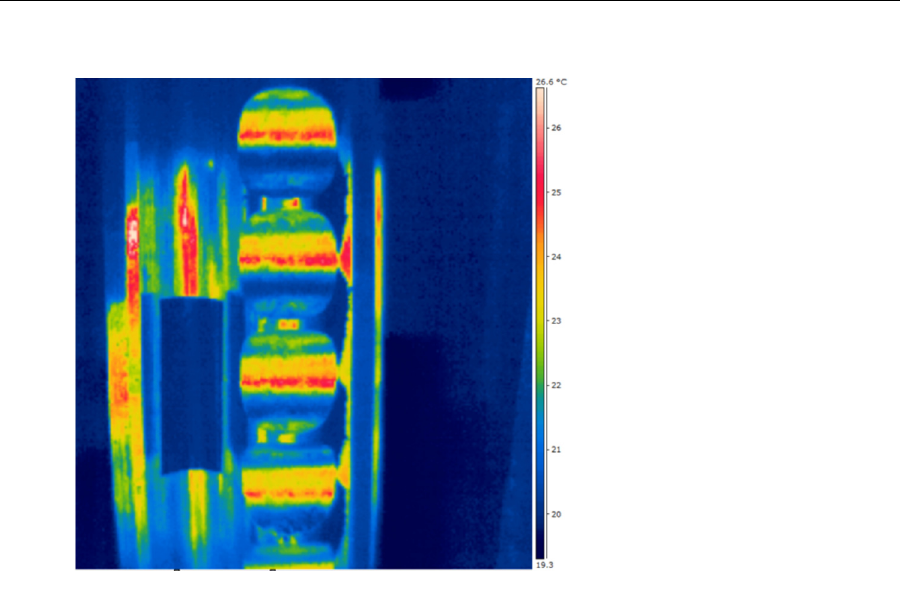
Figure 13. Working roller thermogram with reflections of radiation before briquetting process .